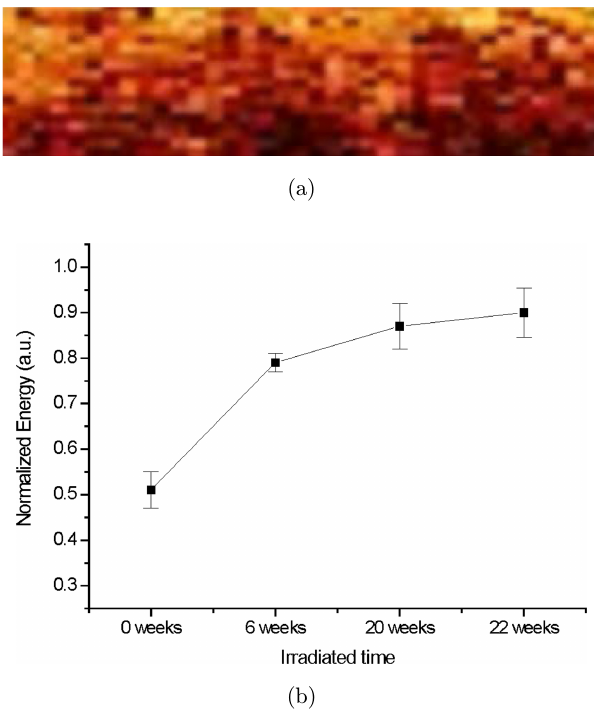
Fig. 4. (a) The region of OCT image for texture analysis, the size is about 1 mm (cid:2) 0 : 25 mm; (b) the energy of skin in OCT image at di®erent time points.